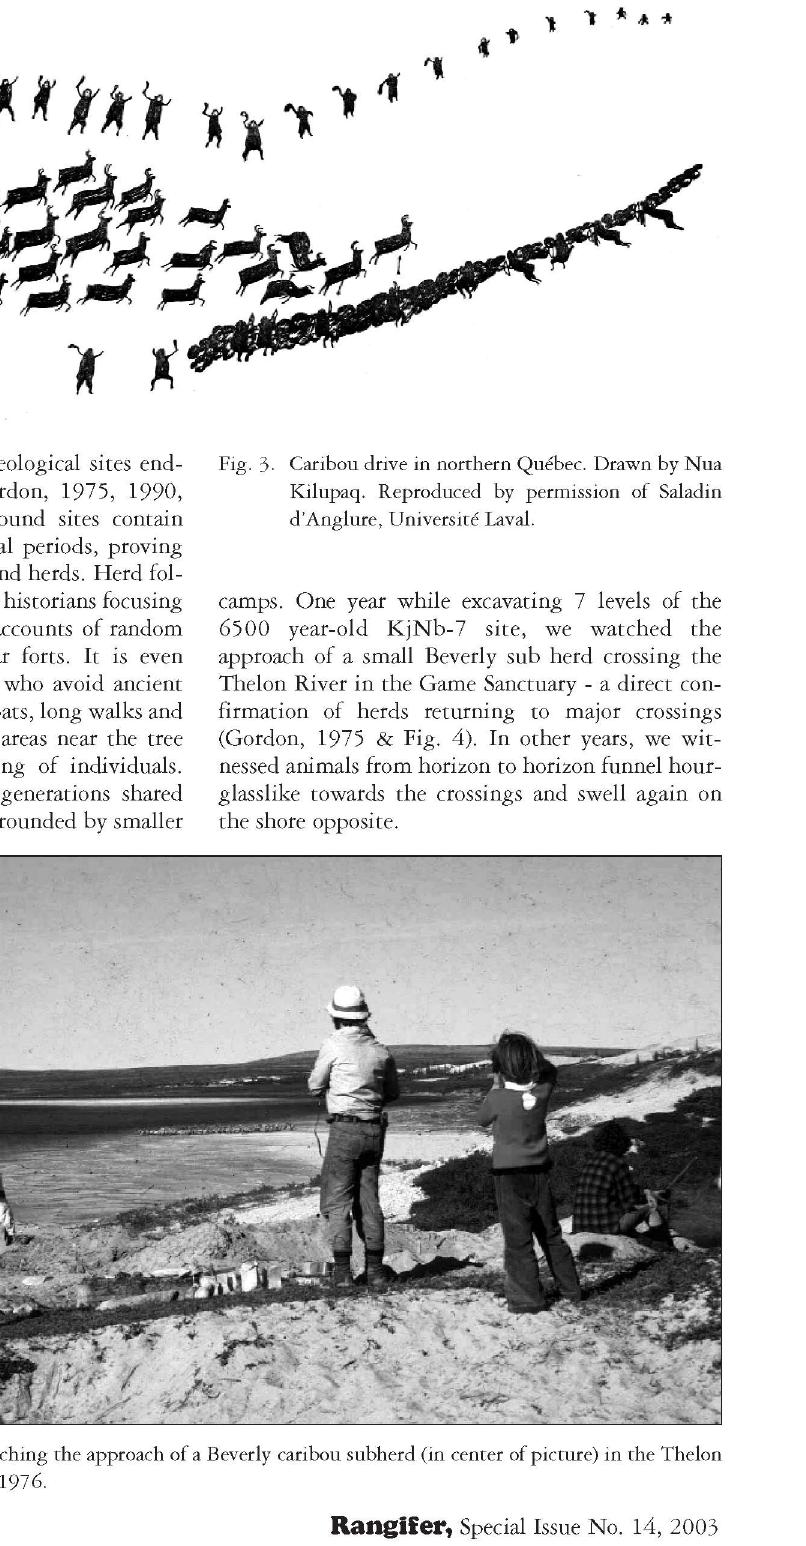
Fig. 4. KjNb-7 excavation crew watching the approach of a Beverly caribou subherd (in center of picture) in the Thelon Game Sanctuary, N.W.T. in